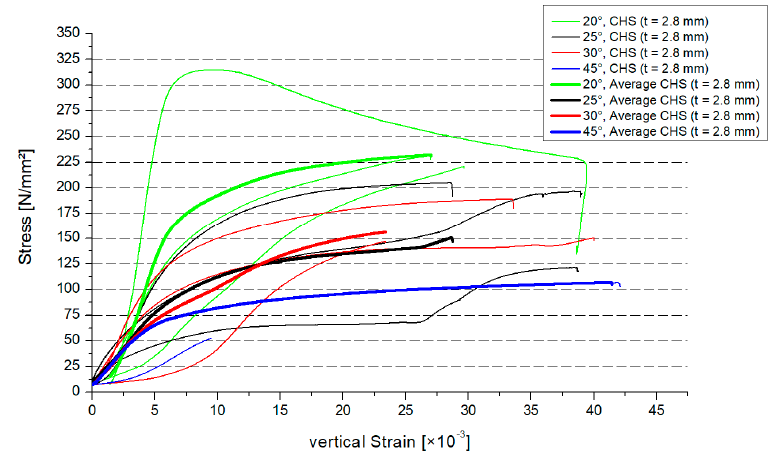
Figure 8. Stress–strain distribution, CHS t = 2.8 mm.